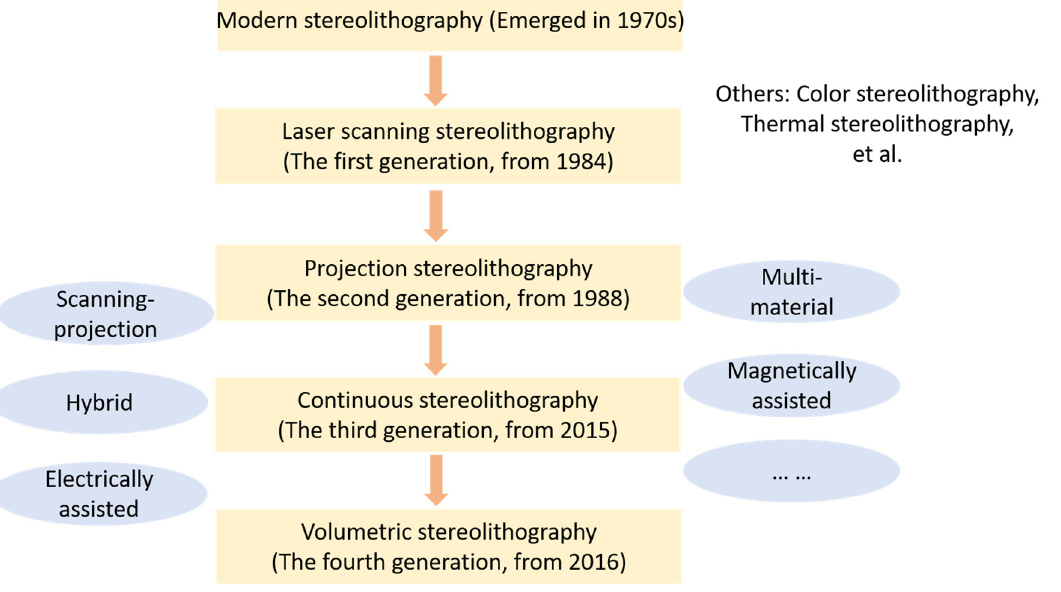
Figure 2. The overview of stereolithography [18,19,22–29]. As supplements, other kinds of processes